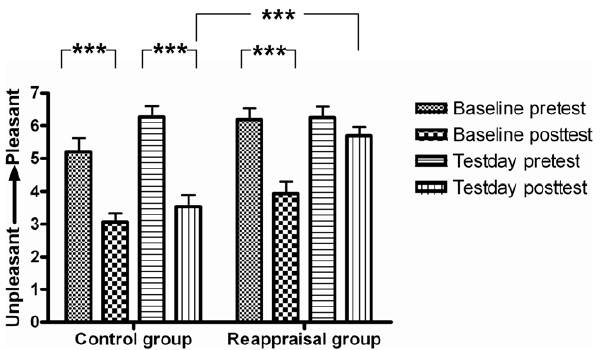
Figure 2. Changes of unpleasantness level. Unleasantness level at the pretest and posttest in the baseline and test days for the control and the reappraisal group. Notably, passively viewing unpleasant pictures significantly increased unpleasant (or decreased pleasantness) for both the two group. The unpleasantness significantly decreased in the reappraisal group in comparison to that of the control group.